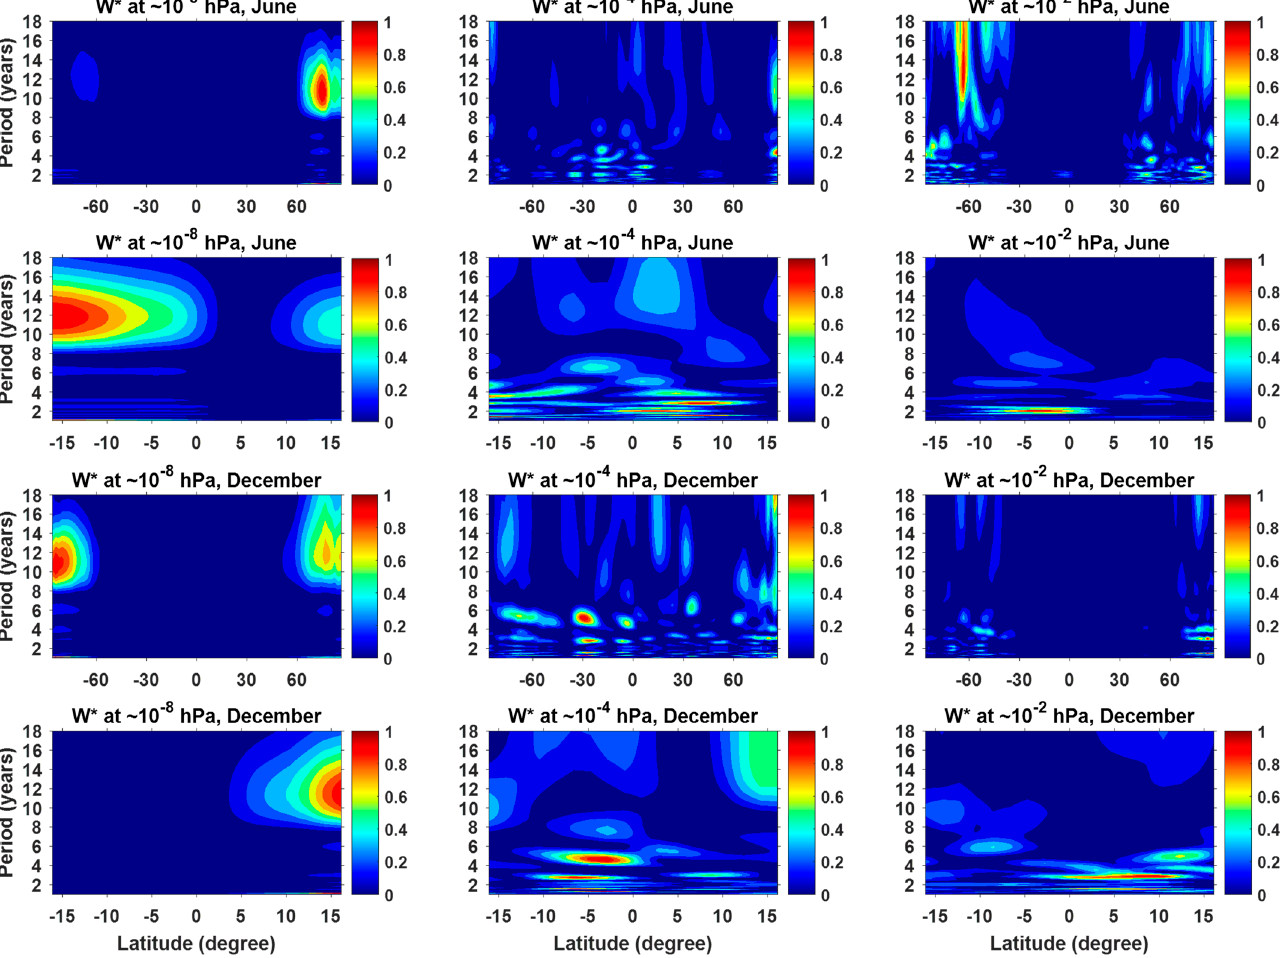
Figure 12. Spectra for the vertical components of atmospheric circulation at ~10 − 8 hPa (left column), ~10 − 4 hPa (middle column), and ~10 − 2 hPa (right column) in June (first two rows) and December (last two rows).